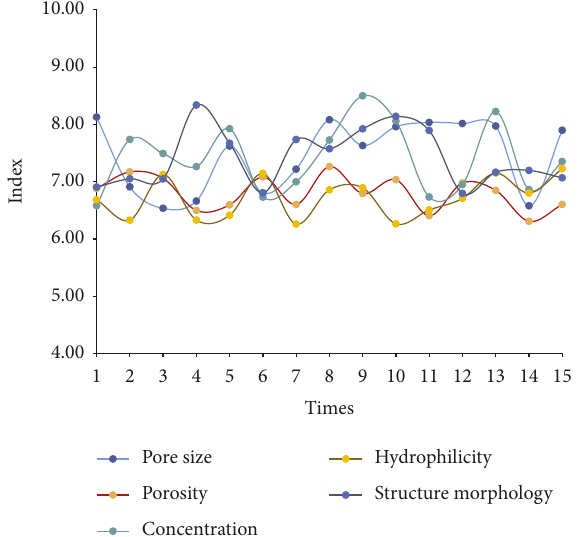
Figure 3: Simulation index results such as pore size and porosity.